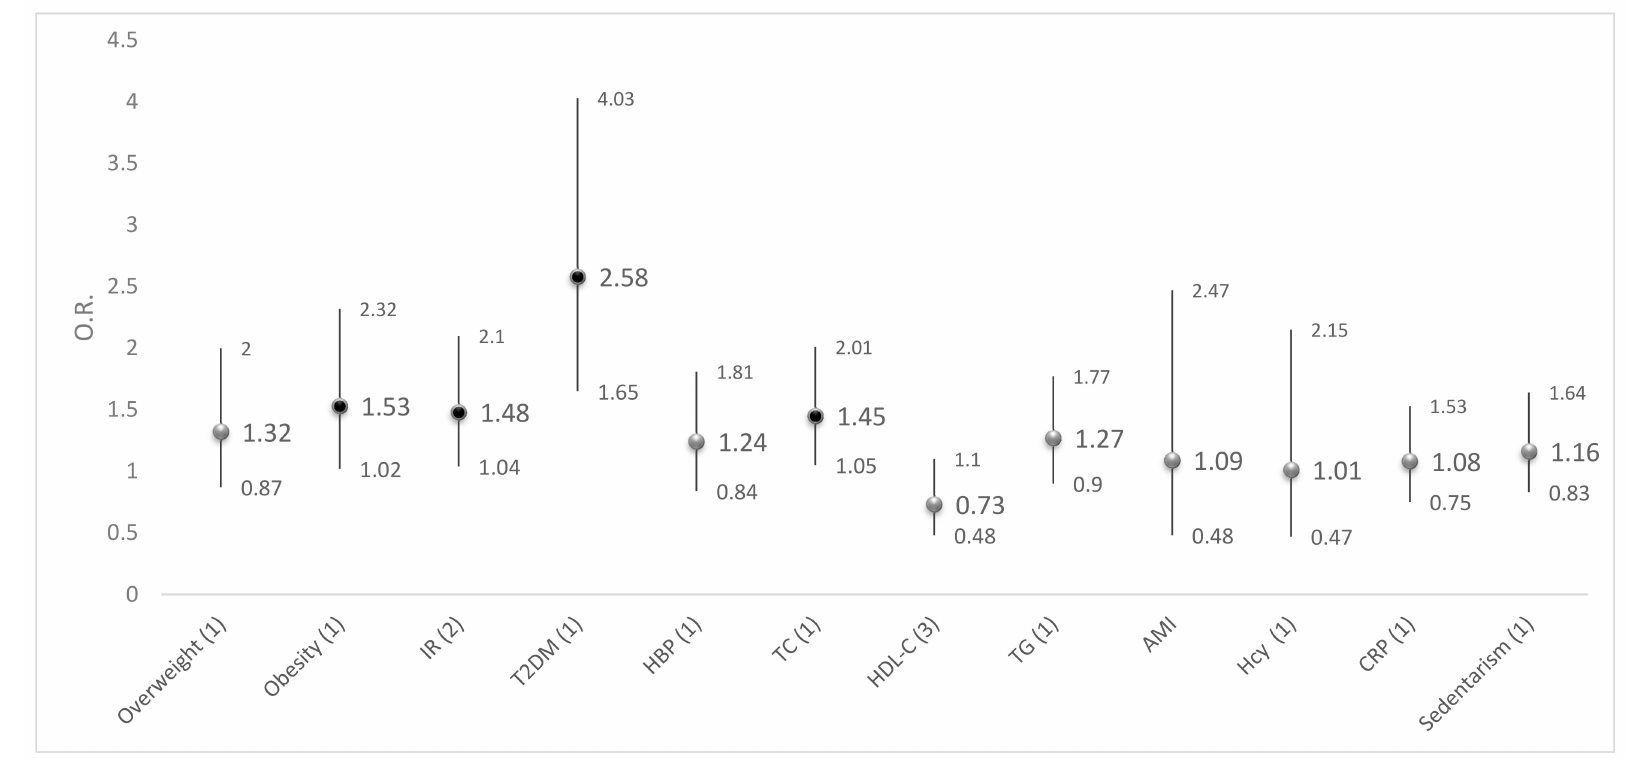
Figure 2. Odds ratios (OR) and 95% confidence interval adjusted for cardiovascular risk factors by vitamin D deficiency in Mexican women aged 20–49 years. BMI: body mass index; PA: physical activity; T2DM: type 2 diabetes mellitus; IR: insulin resistance; HBP: high blood pressure; TC: total cholesterol; HDL-C: high-density lipoprotein; TG: triglycerides; AMI: acute myocardial infarction; Hcy: homocysteine; CRP: C-reactive protein. (1) All models were adjusted by area (urban / rurality), region of the country, Wellbeing index tertiles, ethnicity and the following risk factor variables: HDL-C ( < 50 mg / dL), TG ( < 150 mg / dL), TC ( < 200 mg / dL), HBP, T2DM, CRP ( < 5 mg / dL), Hcy ( < 10 umol / L), sedentarism, overweight–obesity, IR, and AMI, except by the risk factor studied in the particular model. (2) Adjusted by all variables in model 1 excluding T2DM. (3) Adjusted by all variables in model 1 excluding TC. Black circle indicate a statistical di ff erence ( p value <